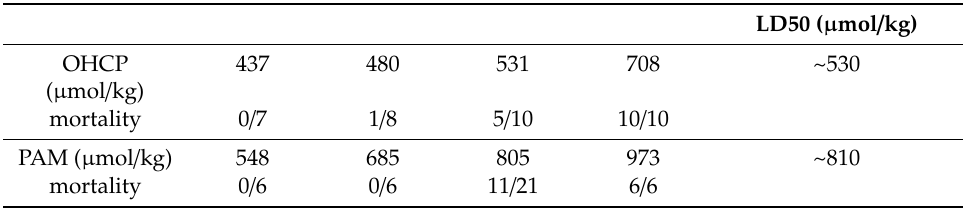
Table 2. Acute toxicity of OHCP and PAM in male nude mice, single intraperitoneal injection, observation period 30